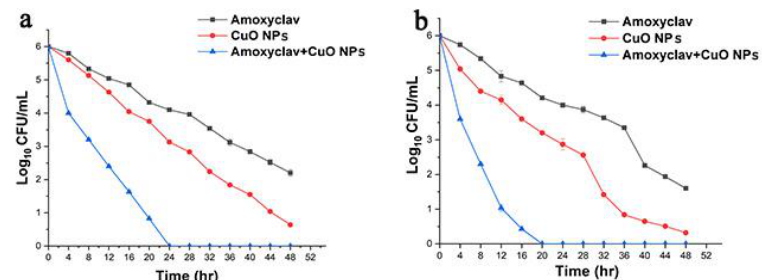
Figure 4. Time-dependent destruction of bacteria by amoxyclav and CuO NPs on ( a ) P. mirabilis ; and ( b ) S. aureus.